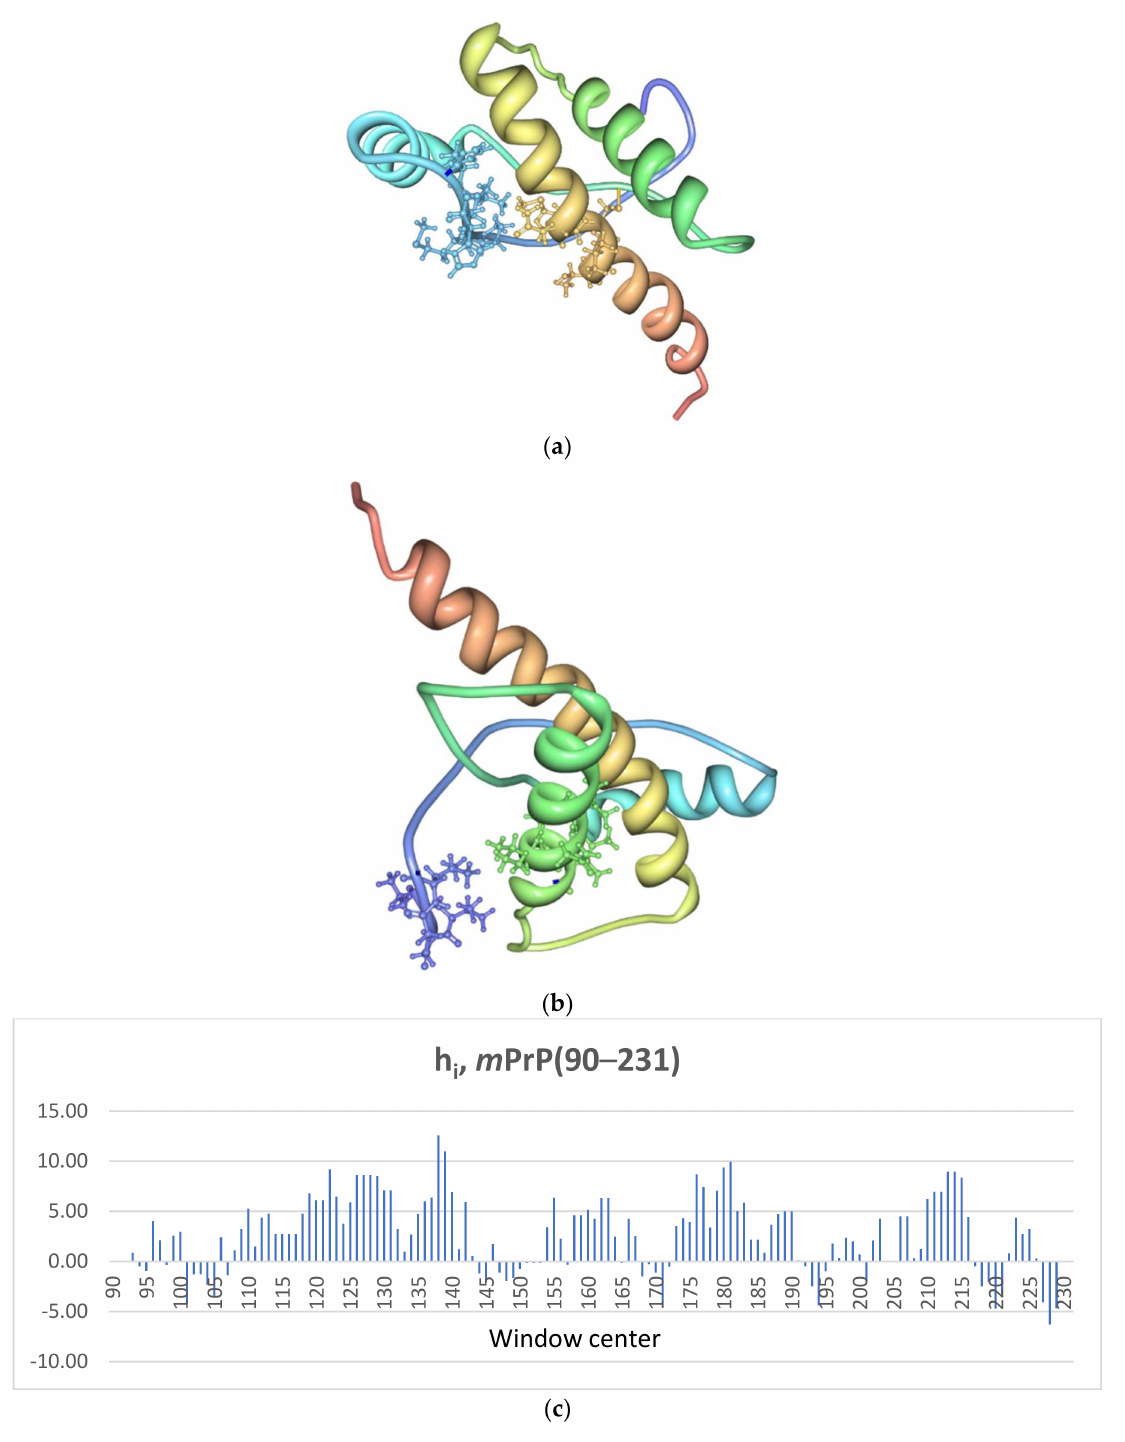
Figure 1. The location on the native structure [36,44] of m PrP(121–231) of the two possible primary contacts: ( a ) contact (138–213), and ( b ) contact (122–181) [45]; ( c ) the hydrophobicity coefficients h i calculated employing a rolling 5-amino acid window (see Section 4.2 in